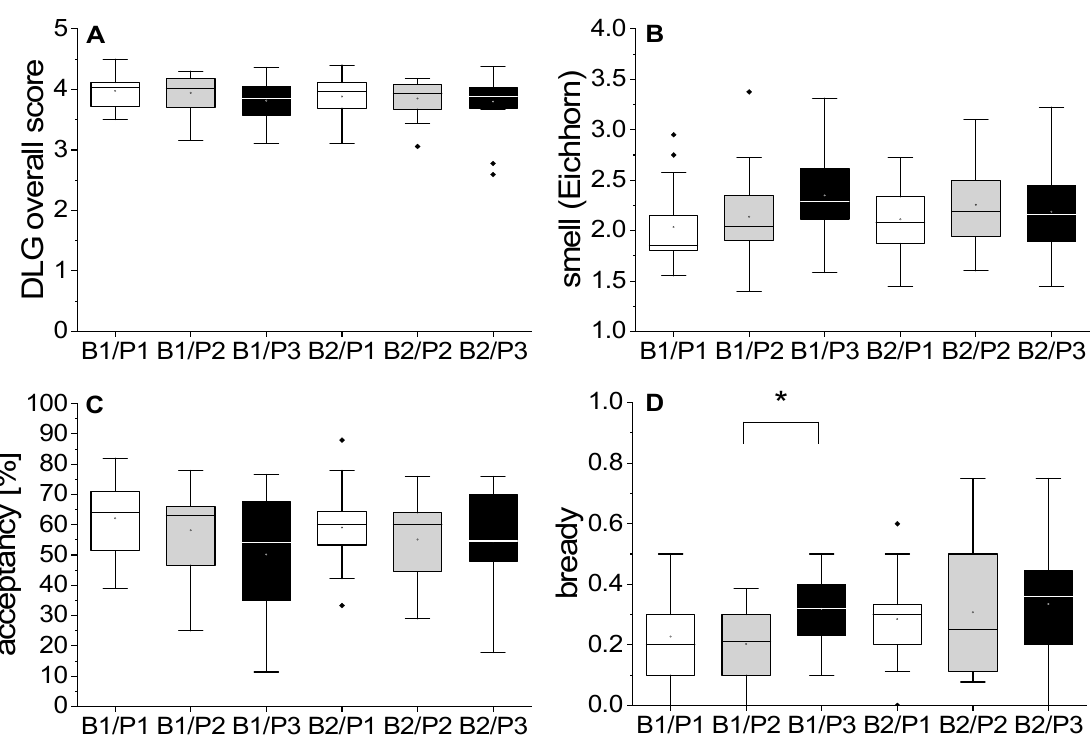
Figure 1. Sensory analysis of beers: ( A ) DLG overall score, ( B ) smell according to the Eichhorn scheme, ( C ) acceptancy (%), and ( D ) attribute bready. Boxplots show values of all aging points ( n = 18). Linked boxplots showed a significant difference (*: p < 0.05). (B1: barley variety 1; B2: barley variety 2; P1: low proteolytic malt modification; P2: medium proteolytic malt modification; P3: high proteolytic malt modification).